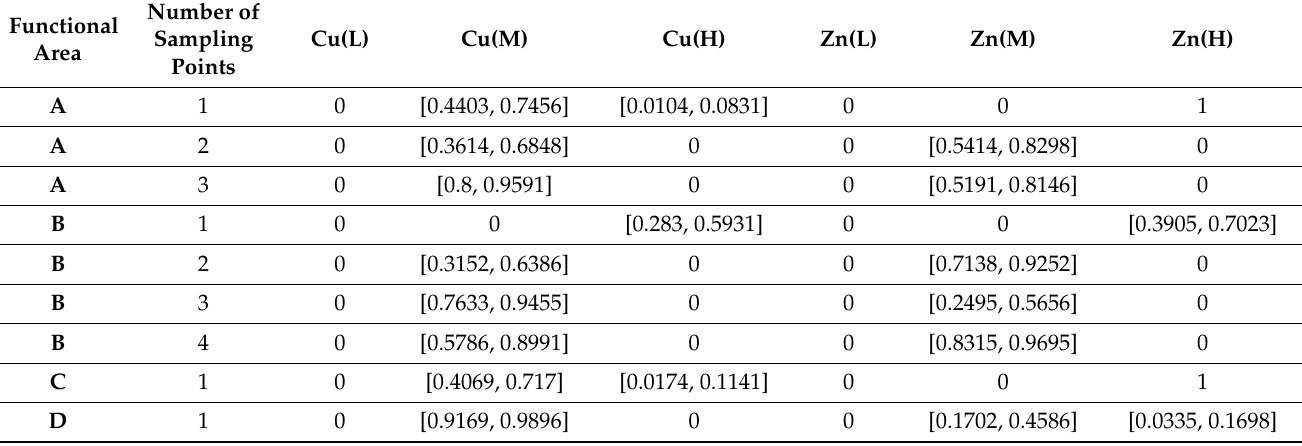
Table 2. The interval membership of the fuzzy attribute of the sampling